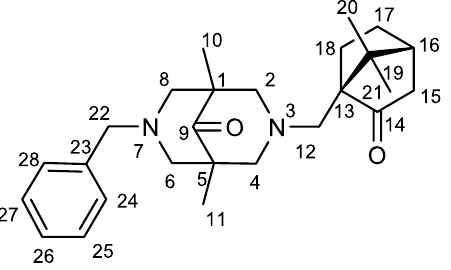
Figure 3. The structure of compound 37 with atom numbering scheme. Bispidinone 24 , (100 mg (0.38 mmol)), 107 mg (0.38 mmol) of iodine derivative 31 , 160 mg (1.14 mmol) of anhydrous K 2 CO 3 and 6 mL of CH 3 CN were added to the vial for the microwave reactor. The mixture was stirred until the organic substrates dissolved and put in the MW-reactor (temperature 75 ◦ C, time 10 h). After completion of the reaction, the precipitate was separated, washed with EtOAc (2 × 10 mL). The organic phases were combined and evaporated. The resulting mixture of the desired product and starting compounds was purified by column chromatography on silica gel (2.5 g silica gel, eluent n-C 6 H 14 /EtOAc with the addition of 1 mL Et 3 N per 50 mL eluent). The desired product was isolated in an amount of 53 mg (34% yield). 1